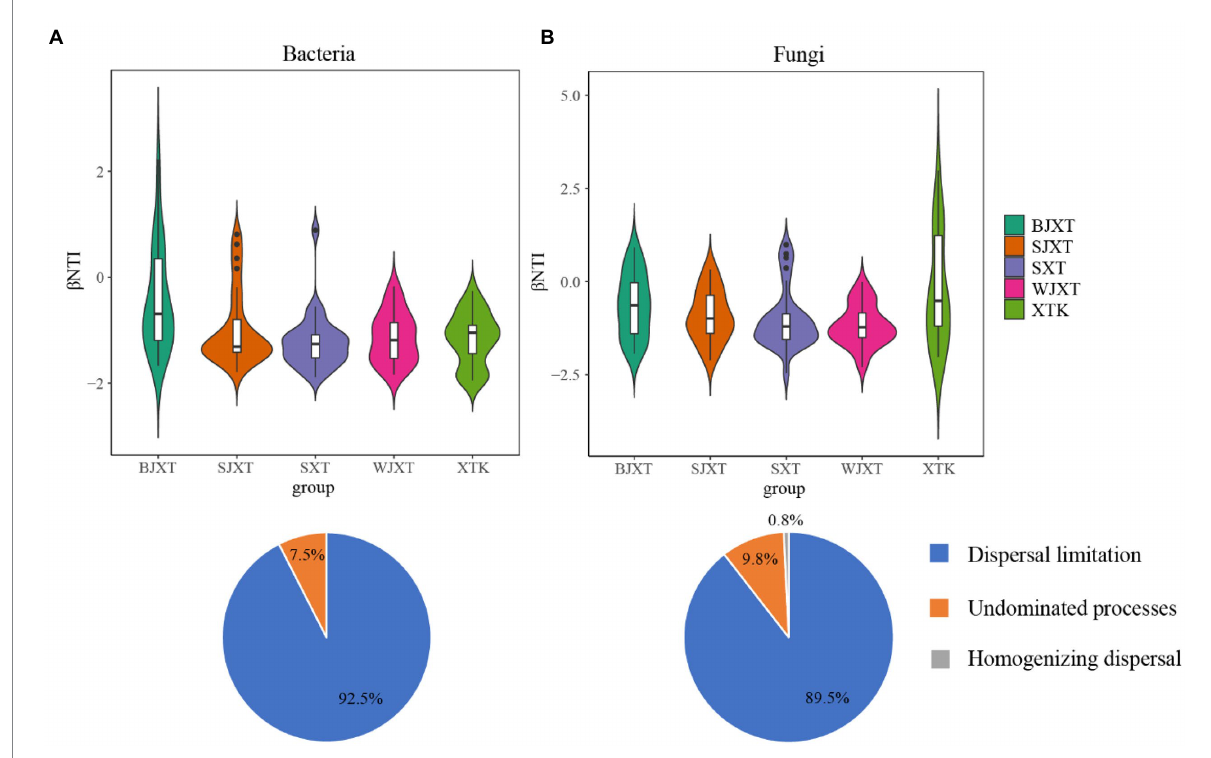
FIGURE 5 Phylogenetic and null model analyses revealing assembly processes of bacterial (A) and fungal (B) communities in five karst tiankeng tested by